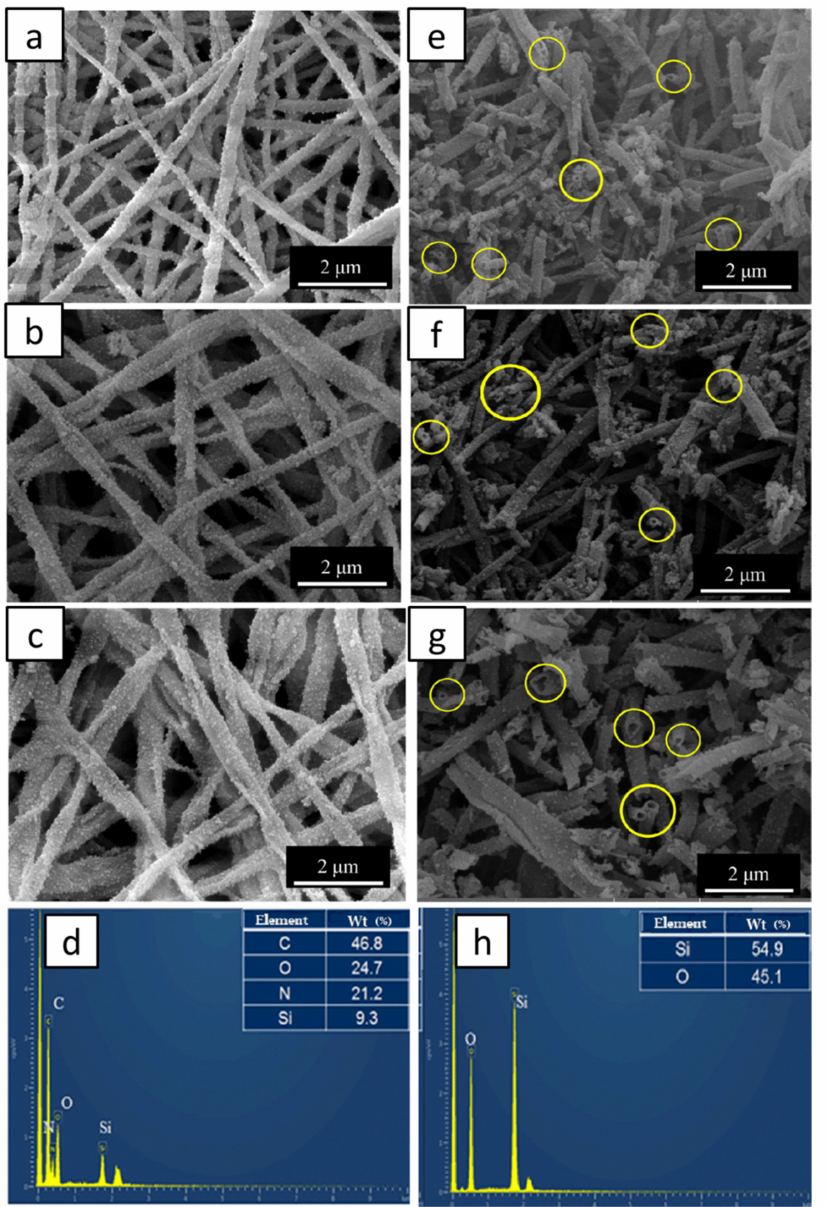
Figure 3. SEM images and EDS spectrum of SF@silica nanofibers (NFs) prepared from the SF fiber templates with the concentration of CaCl 2 at 3, 5, and 8 ( w/v ) % when SF concentration was 15 ( w/v ) %, respectively, ( a – d ) before the calcinations of the SF@silica NFs, ( e – h ) after the calcinations of the SF@silica